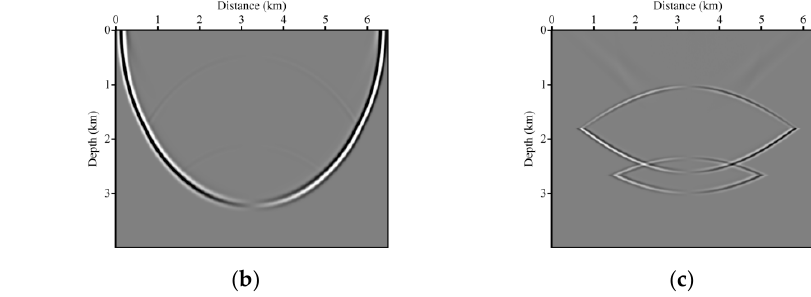
Figure 2. 𝑥 -component of particle-velocity wavefield: ( a ) Coupled wave; ( b ) Pure P-wave; ( c ) Pure S-wave. To reduce the shielding effect of the overburden rock on seismic waves, we simulate the wavefield based on SVDWE. Here, the second interface is set as the stained target. (cid:101) c P is obtained by c P multiplied 10 − 6 in the target area while is zero in other locations. The setting of (cid:101) c S is similar to that of (cid:101) c P . Considering the similarity between (cid:101) c P and (cid:101) c S models, only one of them is shown in Figure 1b. By solving SVDWE, the stained wavefield (cid:101) V is generated after the V hits the stained target. The stained wavefield (cid:101) V only contains the reflection and transmission about the second interface as exhibited in Figure 3. Consequently, we infer that imaging with the stained wave can reduce interference from non-target structures.